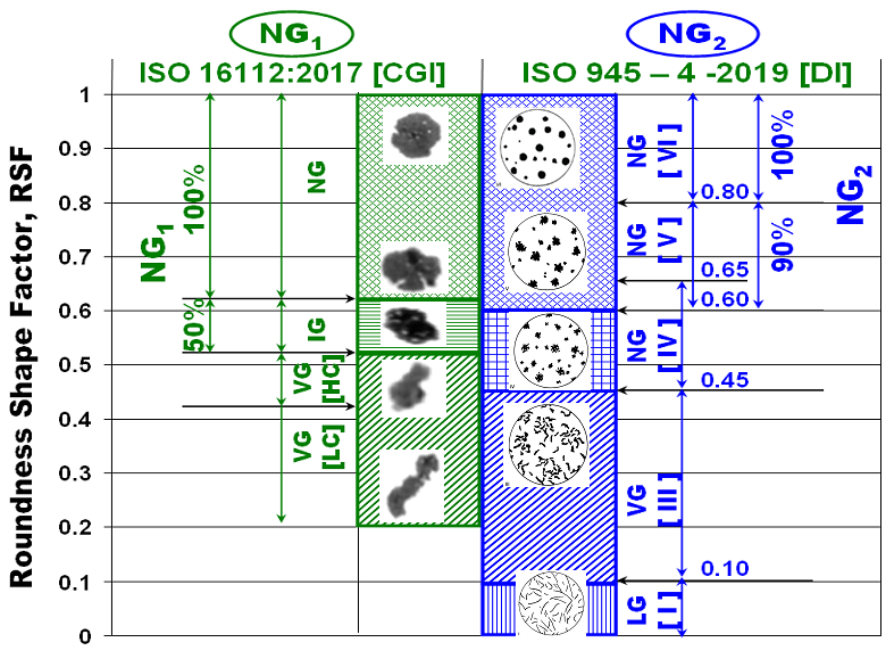
Figure 4. Graphite morphologies and Roundness Shape Factor (RSF) involved in the graphite nod- ularity calculus, according to ISO 16112-2017-CGI (NG 1 ) and ISO 945-4-2019-DI (NG 2 ).